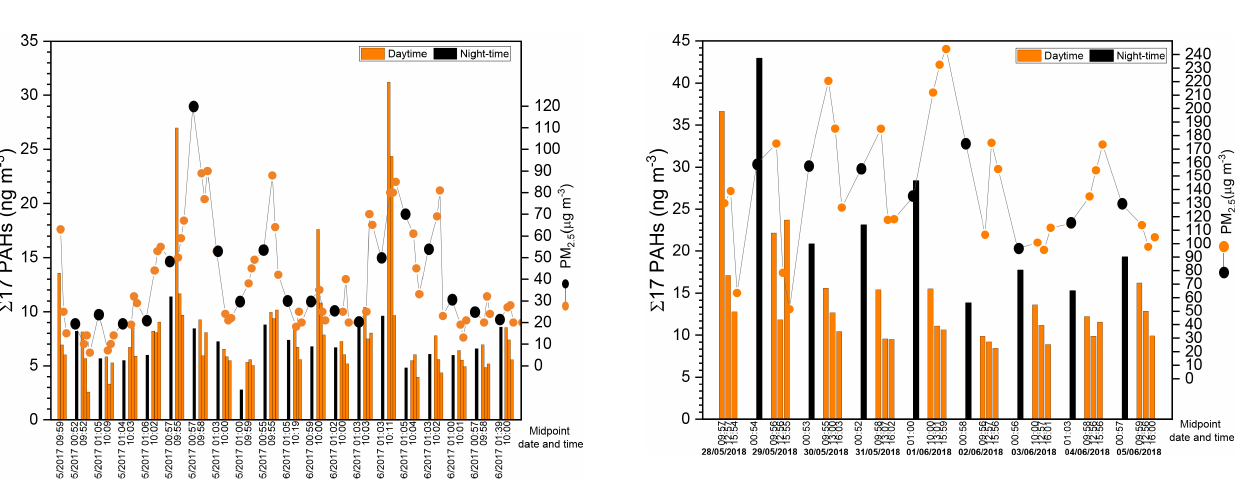
Figure 2. Temporal variation of total PAHs and PM 2 . 5 concentra- tions in summer Delhi. PM 2 . 5 concentrations were averaged to the filter sampling time, approximately 3h in daytime and 15h at